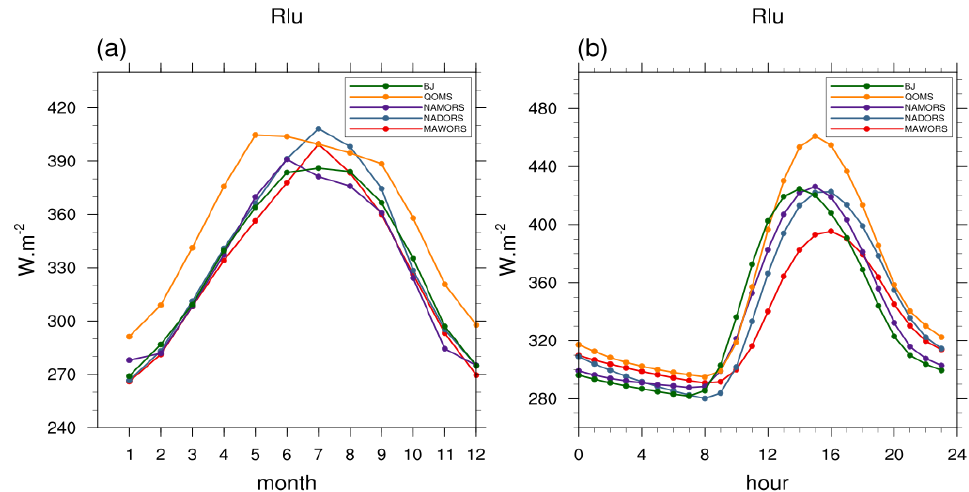
Figure 17. Annual variation of upward longwave radiation ( a ) and diurnal variation of upward longwave radiation ( b ) at each station.